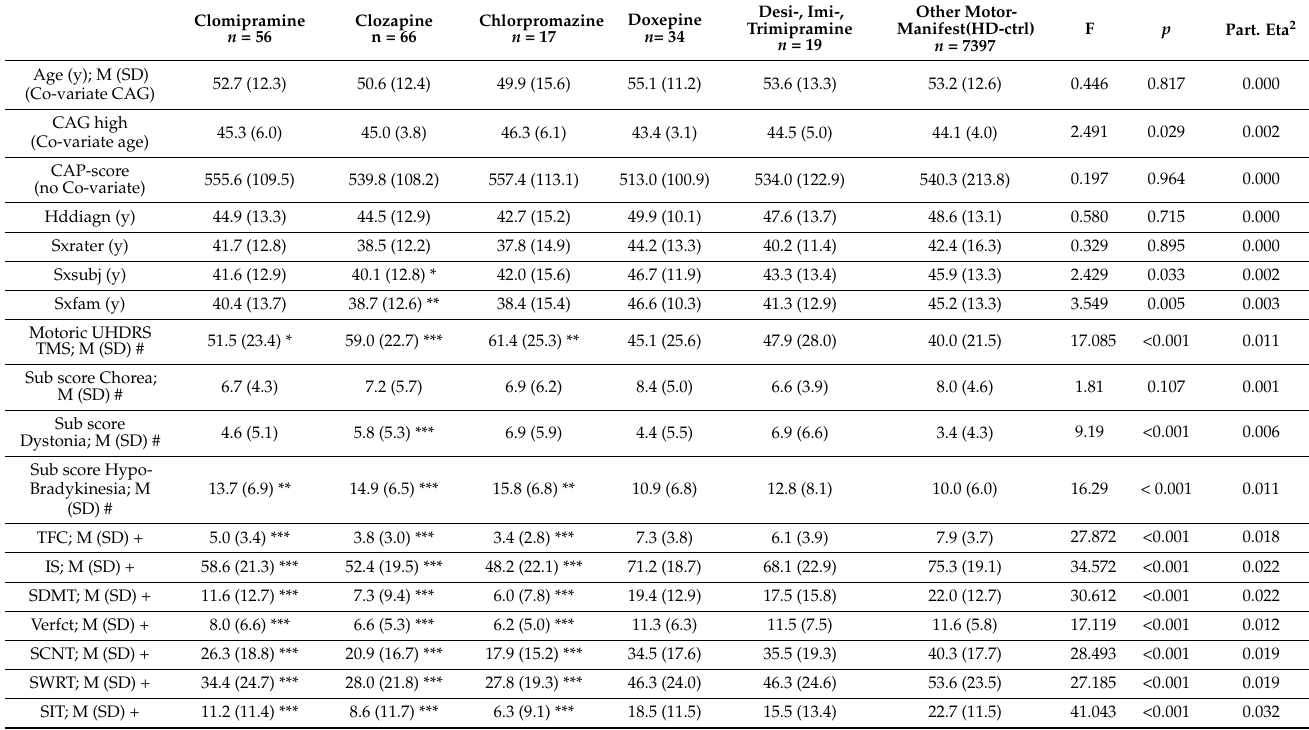
Table 1. Baseline data of HD-ctrl and treated HD